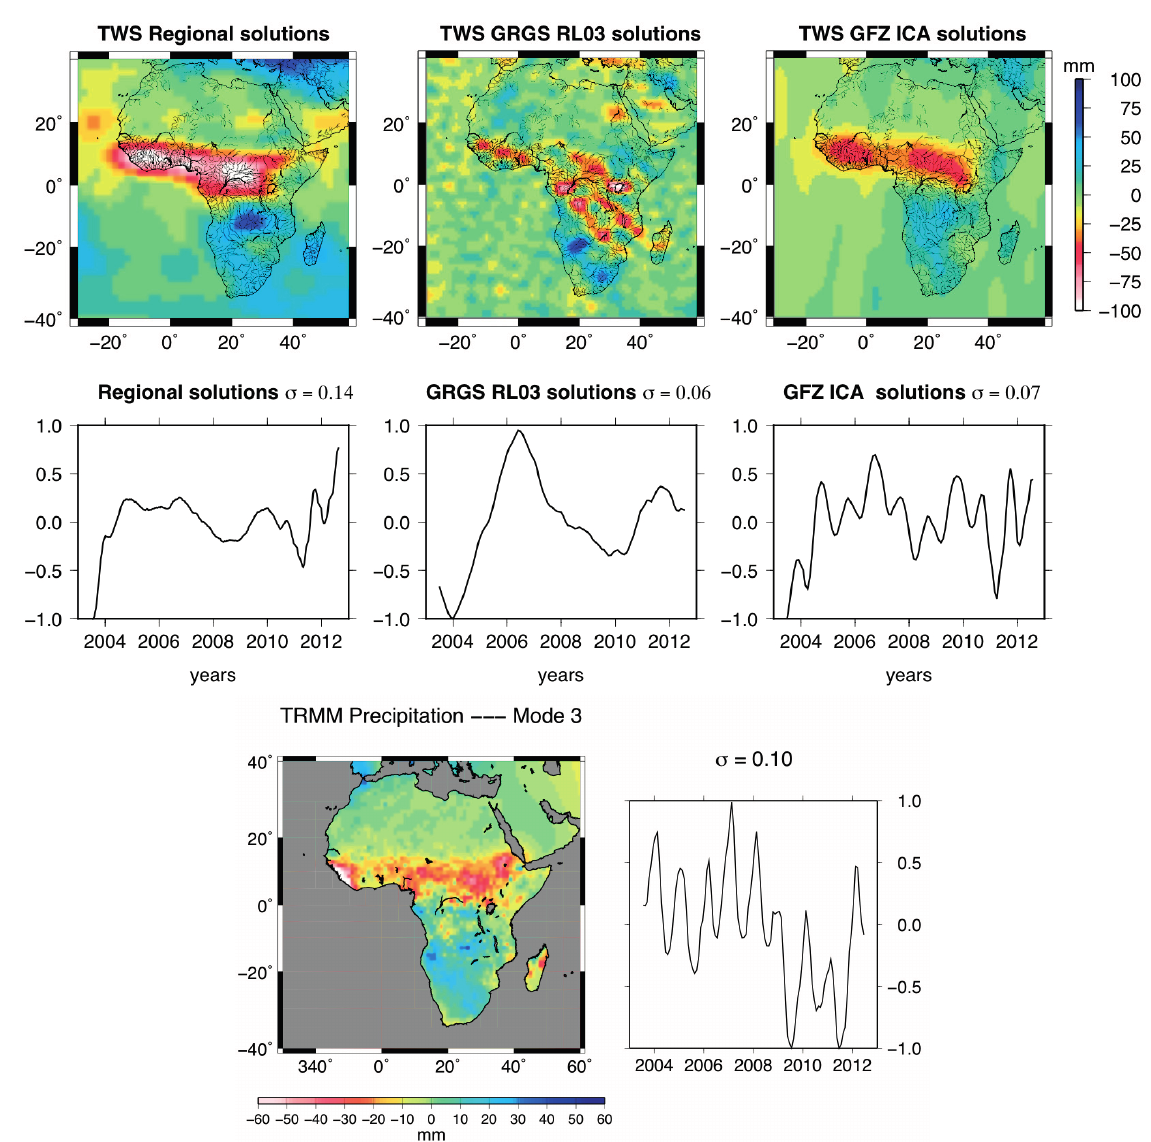
Figure 9. Third spatial ( top ) and temporal ( bottom ) modes of the PCA of the regional, global GRGS and 400-km ICA GRACE solutions. Units are mm